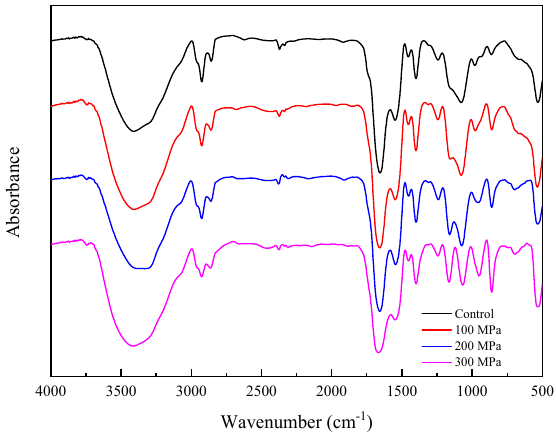
Figure 10. Effect of HHP pretreatment on the FTIR spectra of RBPH. HHP: high hydrostatic pressure;